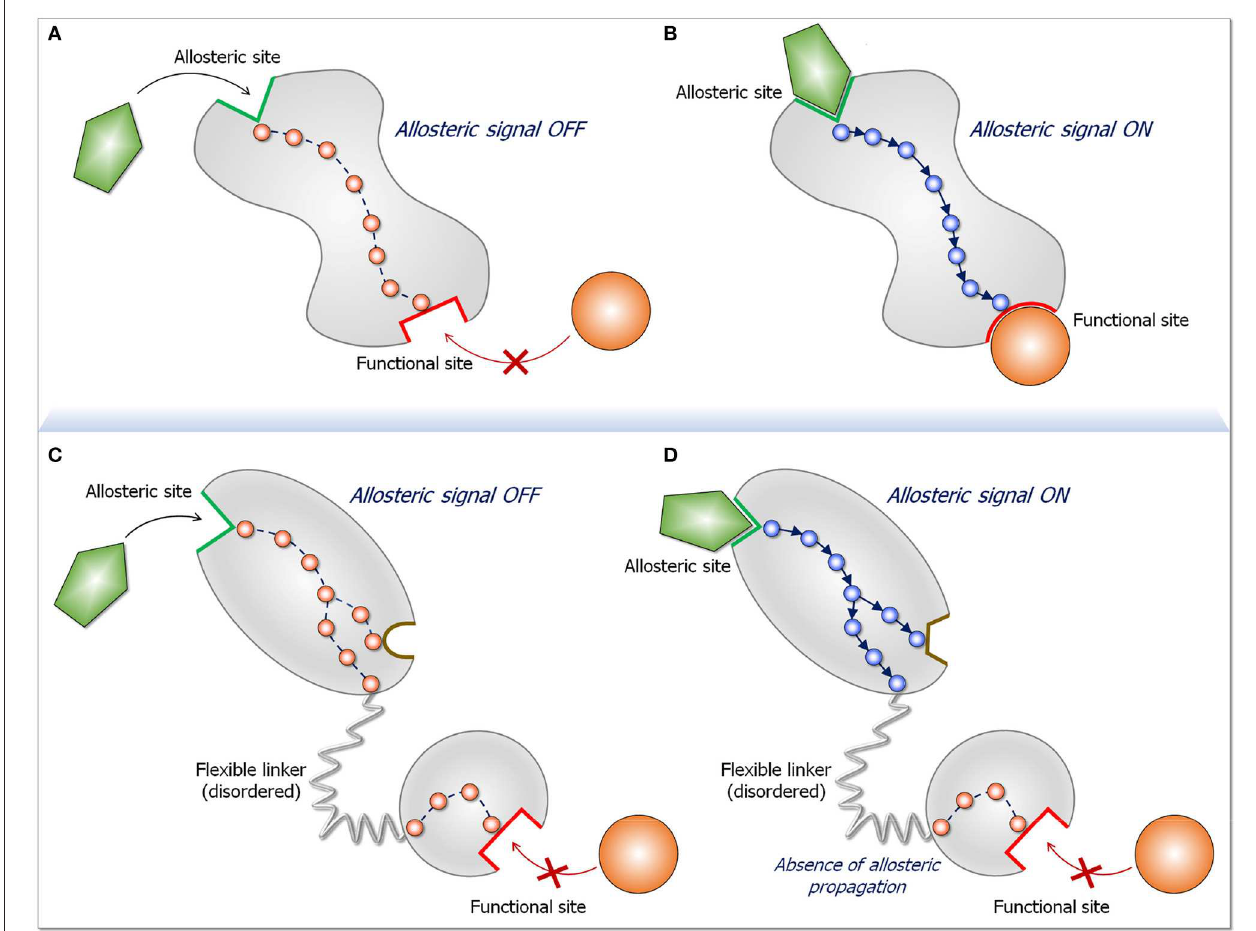
FIGURE 2 | Schematic diagram for an allosteric propagation pathway and its absence in long disordered linkers. The top two panels display a two-state dynamic allosteric switch. Both states pre-exist in the population. In the absence of the ligand (A) the protein populates a conformation in the ligand-free state. Upon ligand binding at the allosteric site (B) , a functional switch that is in favor of a ligand-bound state initiates at the binding site and propagates down to the functional site. The two bottom panels (C,D) depict what happens when two domains are joined by a long, disordered linker. The two-state switch takes place only in the domain to which the allosteric ligand binds, but do not propagate down the linker. The reason for the absence of allosteric propagation through the long linker is that the disordered state is distributed in multiple conformations. Since in the disordered state there are no specific stabilized interactions, there is no preferred propagation pathway. Preferred propagation pathways are required for population shift. In practice, identification of an allosteric propagation pathway in the structure can be achieved through superposition of the two (active and inactive) structures and locating changes in interactions of residues along pathways extending from the allosteric site to the functional